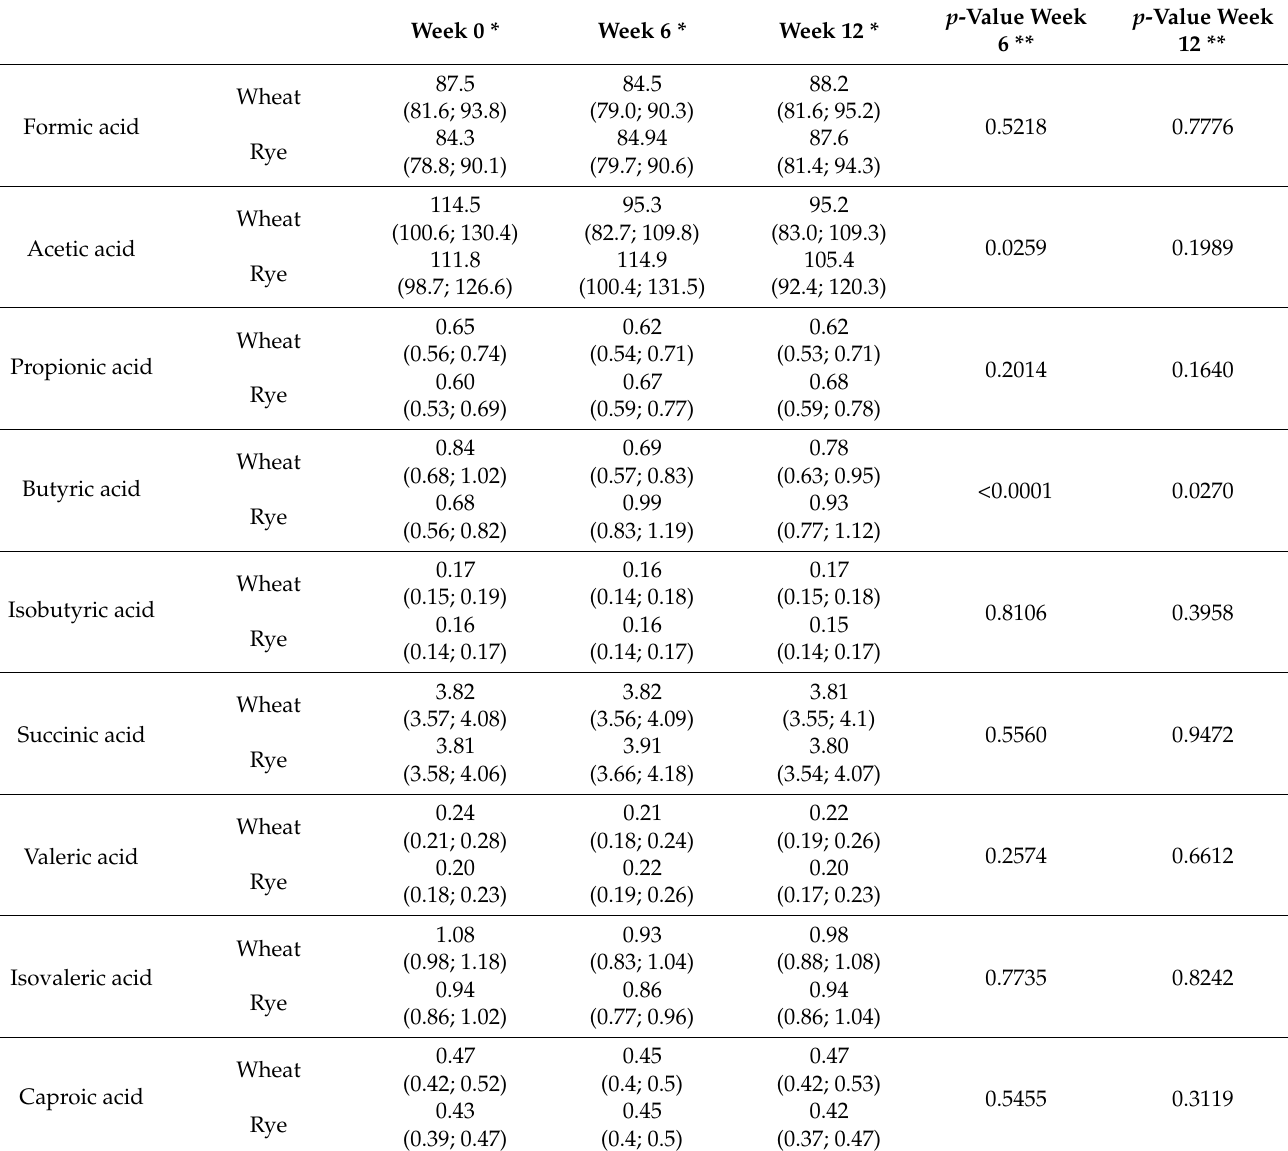
Table 4. Plasma short chain fatty acid concentration ( µ